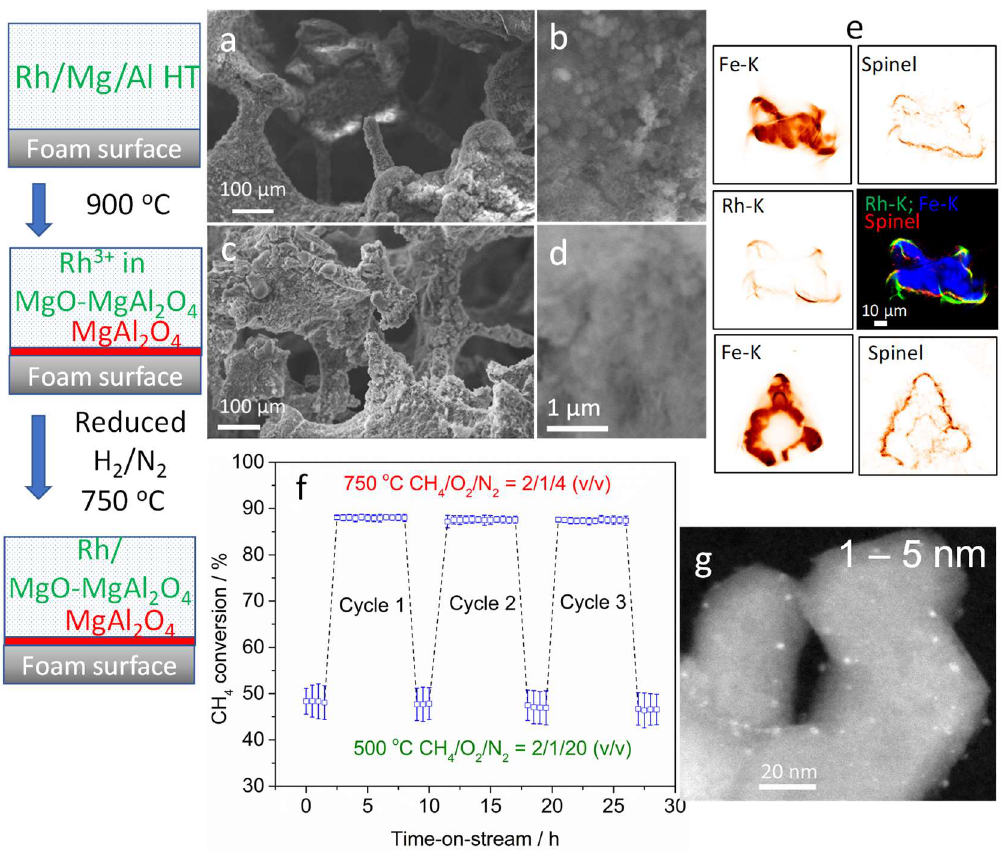
Figure 8. Properties Rh/Mg/Al structured catalysts electrodeposited from 0.06 M electrolyte in a double-compartment flow cell, Rh/Mg/Al = 5/70/25 (a.r.%) nitrate solution (pH 3.8) at −1.2 V vs. SCE for 2000 s: ( a , b ) SEM image of electrodeposited sample at low and high magnification; ( c , d ) SEM image of sample calcined at 900 °C for 12 h at low and high magnification; ( e ) nano-XRF/XRF distribution; ( f ) stability test in the catalytic partial oxidation of CH 4 at different reaction conditions; and ( g ) HR-TEM image of spent catalyst. Adapted from [60].